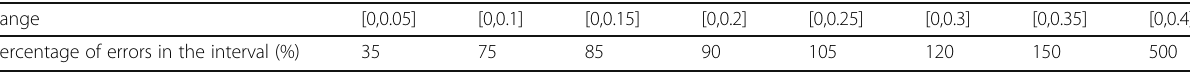
Table 2 Error analysis of calculation result